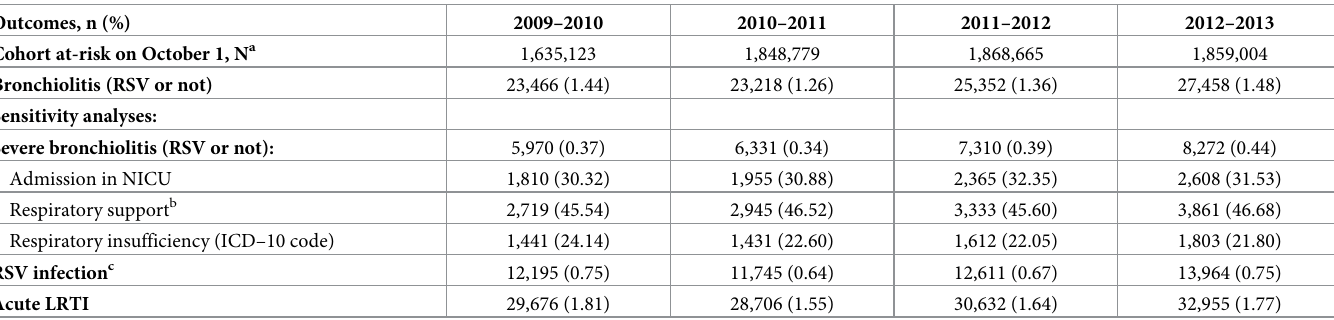
Table 2. Hospital admissions for bronchiolitis, severe bronchiolitis, RSV infection, and acute LRTI over four consecutive bronchiolitis seasons (N =